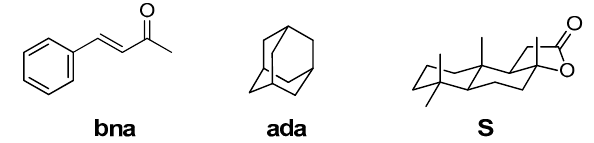
Figure 2. The structures of organic substrates studied.